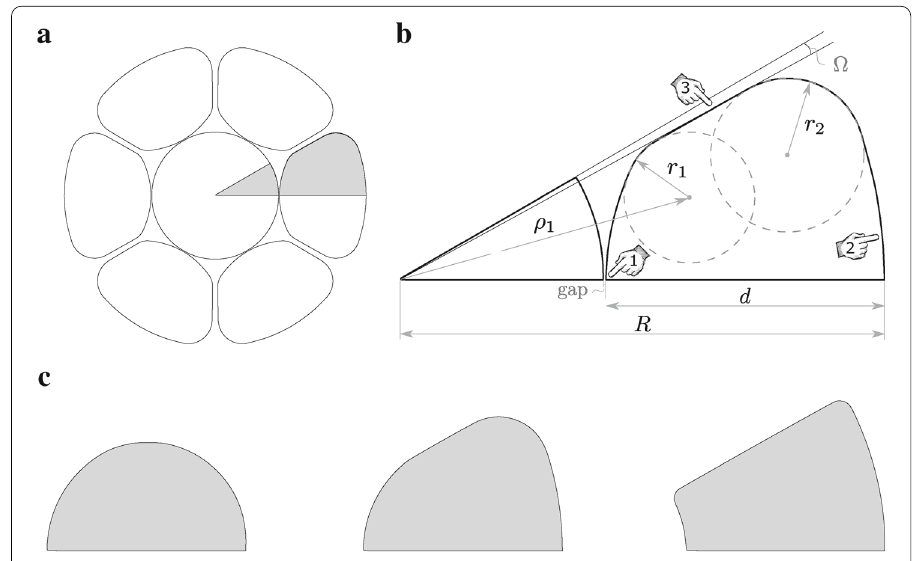
Fig. 8 Geometrical parametrization of the strand cross section. b Strand cross section corresponding to the helical slice depicted in a , where the five parameters required to define the geometry are highlighted and taken as design variables. c Examples of feasible cross sections of the outer